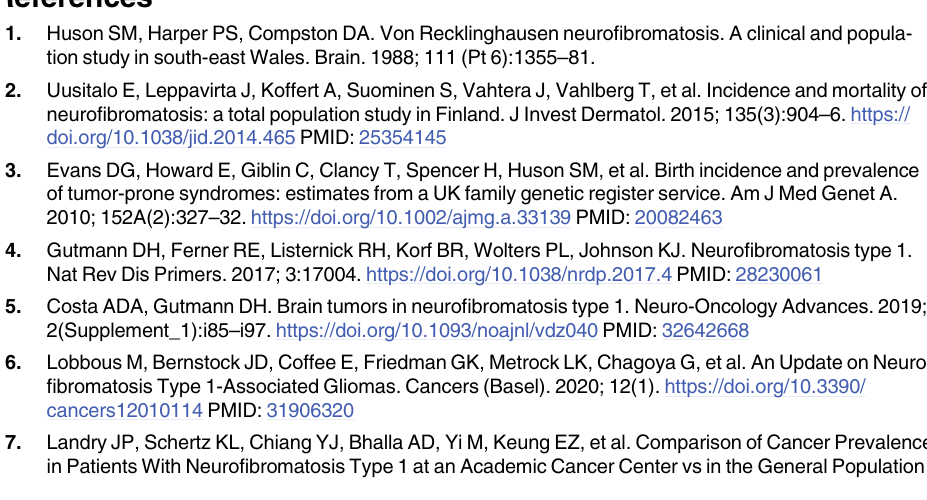
S2 Table. Log2 value of fold change in RFP intensity (spheroid lines 17, 5746 and 5653) or cell number (TM31). Drug sensitivity data expressed in log2 fold change in the different cell lines. A value < 0 denotes that less cells are present compared to day 0. S3 Table. 3D spheroid assay incucyte analysis settings. Incucyte analysis settings and param- eters used to analyze our 3D spheroid assays. S4 Table. 2D cell counting assay incucyte analysis settings. Incucyte analysis settings and parameters used to analyze our 3D spheroid